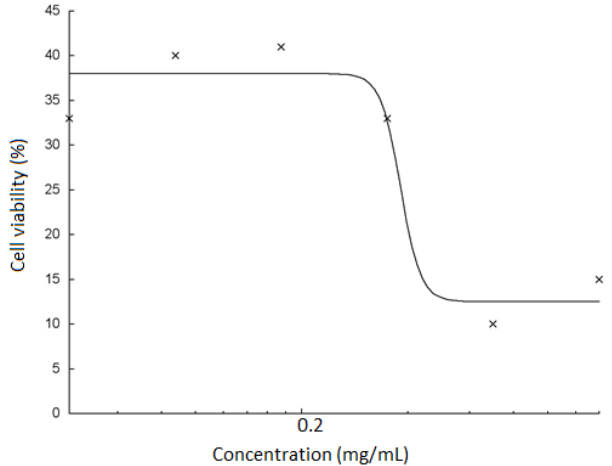
Figure 10. Graph of the percentage of cell viability of gingival fibroblasts in different concentrations of ZnO NPs.